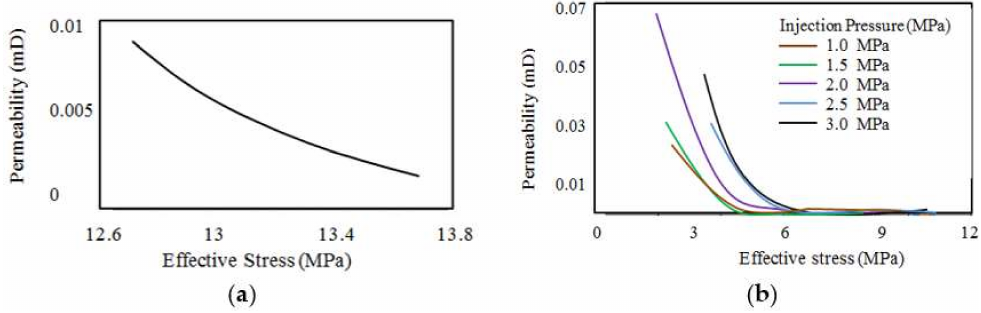
Figure 12. Influence of effective stress on CO 2 permeability in ( a ) high-rank coal [40], and ( b ) low-rank coal